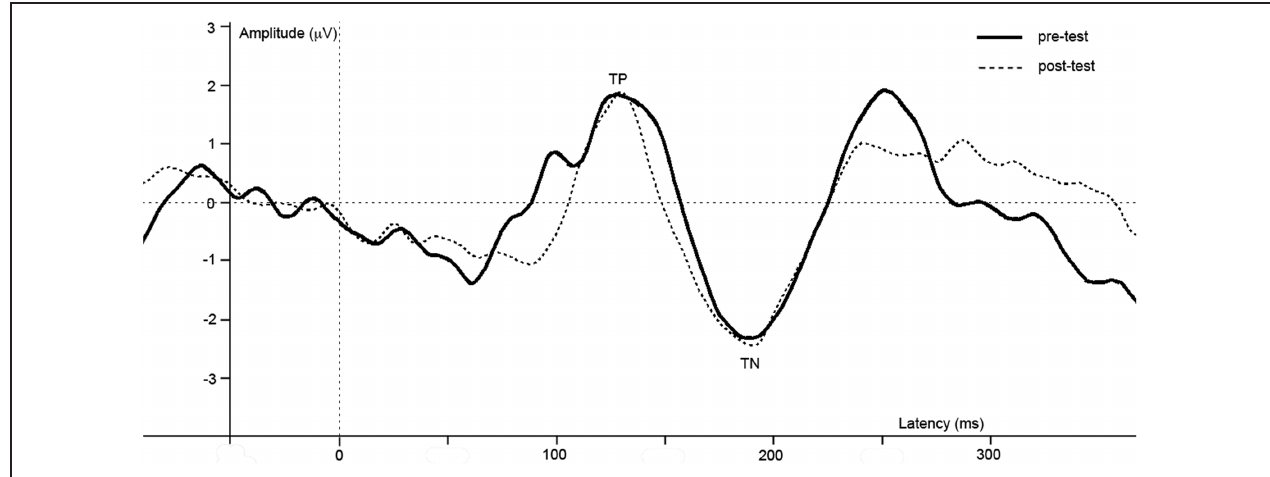
FIGURE 4 | Difference waves of grand averages at Oz electrode evoked by checkered vs. homogeneous stimuli in the pre-test (solid line) and post-test (dashed line) of the long-term